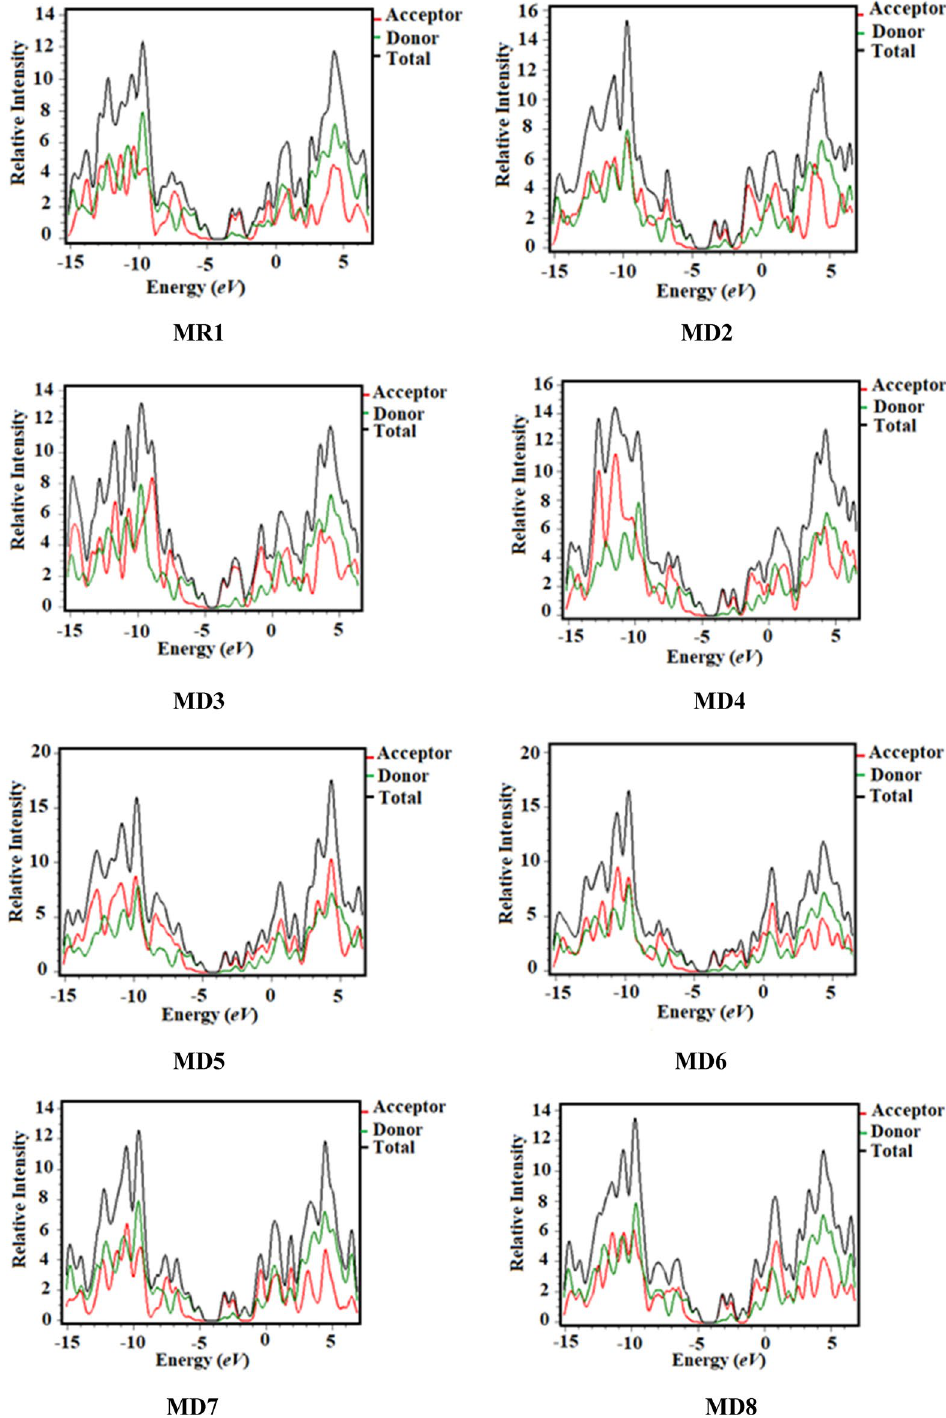
Figure 5. DOS spectra of the studied compounds ( MR1 and MD2–MD8 ) drawn by utilizing PyMOlyze 1.1 version (https:// sourc eforge. net/ proje cts/ pymol yze/). All out put files of entitled compounds were computed through Gaussian 09 version D.01 (https:// gauss ian. com/ g09ci